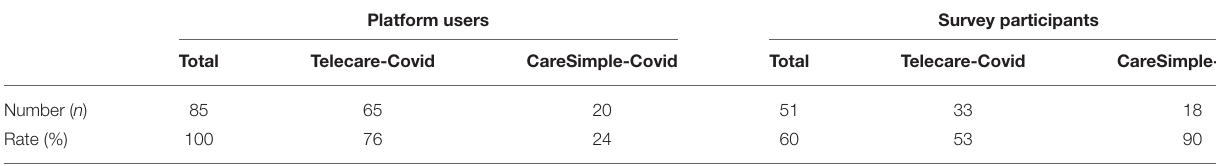
TABLE 2 | Number of users, rate of use, and participation.